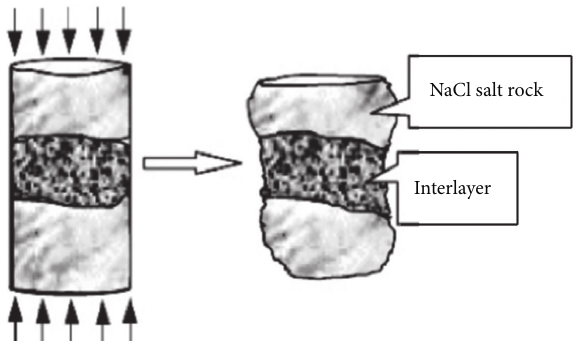
Figure 5: Creep failure sketch map of bedded salt rock